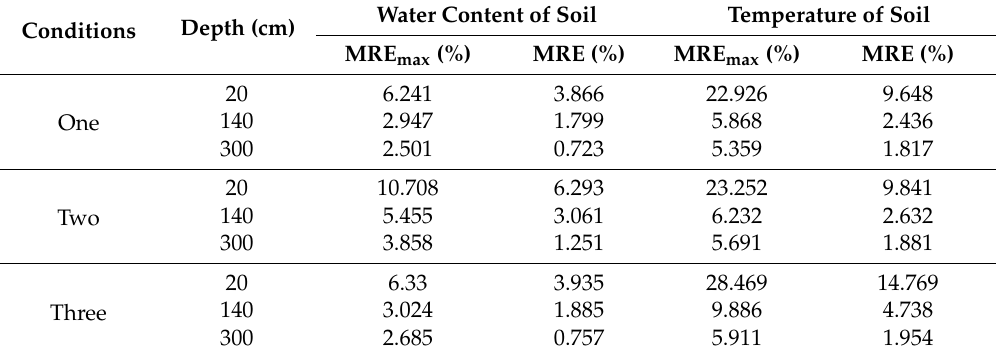
Table 6. Error between simulated and observed values for soil water content and temperature under different